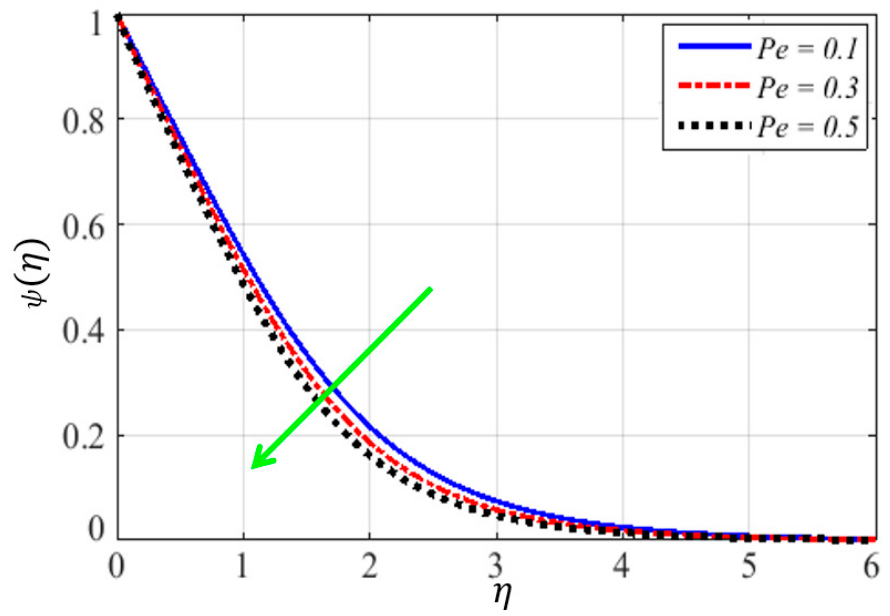
Figure 17. Impact of P é clet number on microorganism density field.